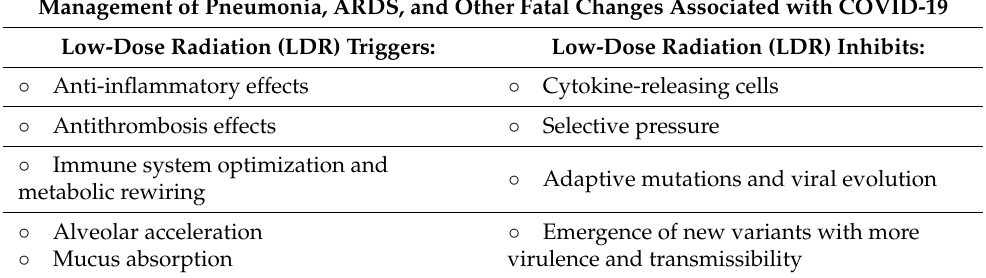
Table 1. Cardinal goals of using LDRT for treatment of COVID-19-associated symptoms. Management of Pneumonia, ARDS, and Other Fatal Changes Associated with COVID-19 Low-Dose Radiation (LDR)